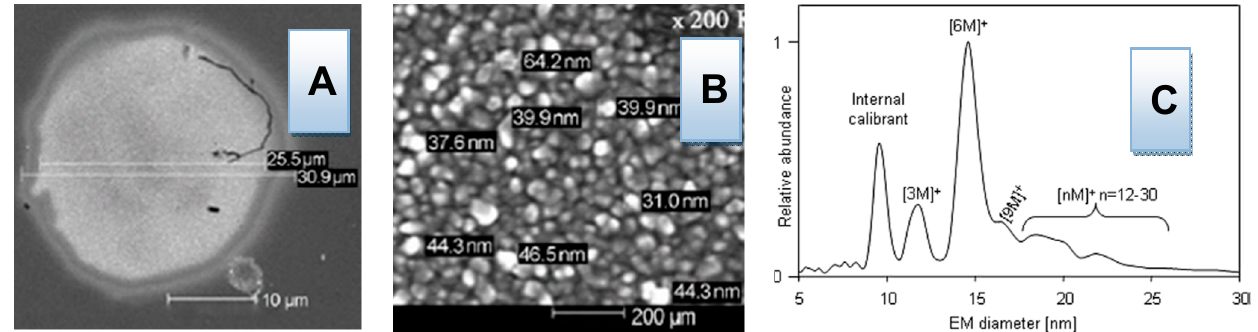
Figure 4. Results of investigation into biomedically active NPs: ( A , B ) SEM-magnified images of gold NPs obtained by cellobiose dehydrogenase treatment of [AuCl 4 ] - (Malel et al., 2010); ( C ) GEMMA spectrum of non-covalent homo-complex of Jackbean urease (Allmaier et al., 2008).